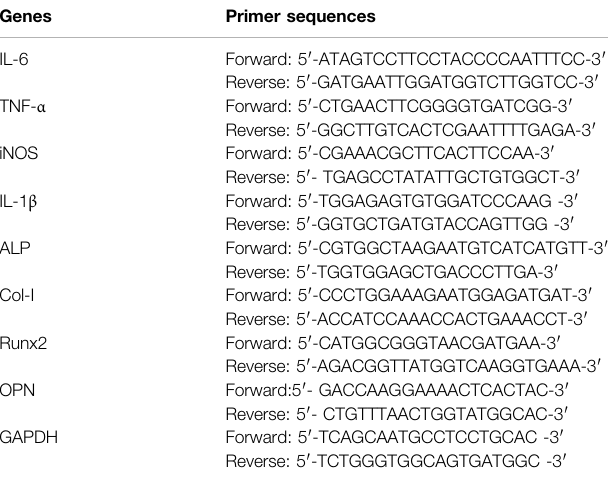
TABLE 1 | Primers used in